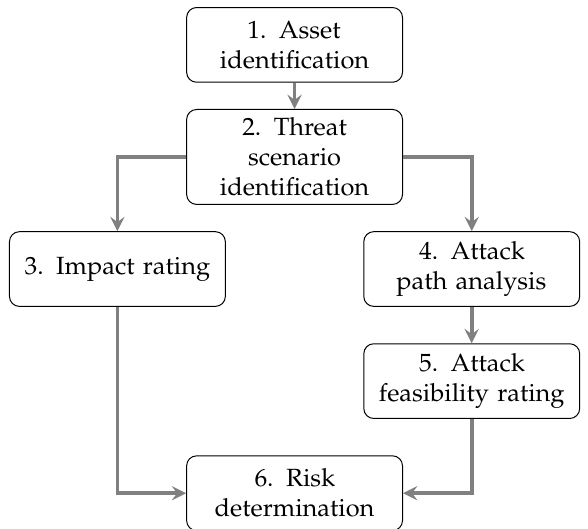
Figure 3. TARA steps provided by ISO/SAE